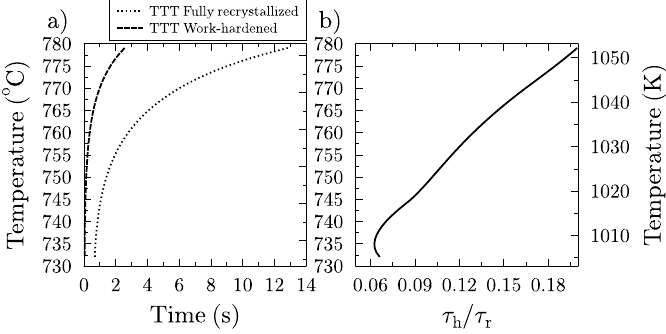
Figure 10. Comparison of the calculated ideal TTT curves of work hardened versus fully recrystallized austenite: ( a ) plots of the TTT curves; ( b ) the time required to start the transformation for strain hardened material divided by the corresponding time for fully recrystallized